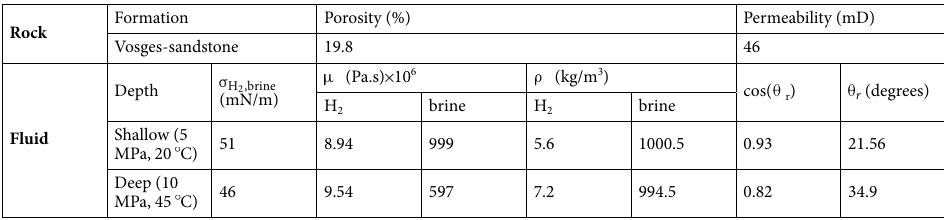
Table 2. Reported fluid and rock properties for H 2 -brine experimental primary drainage tests 2,45 .